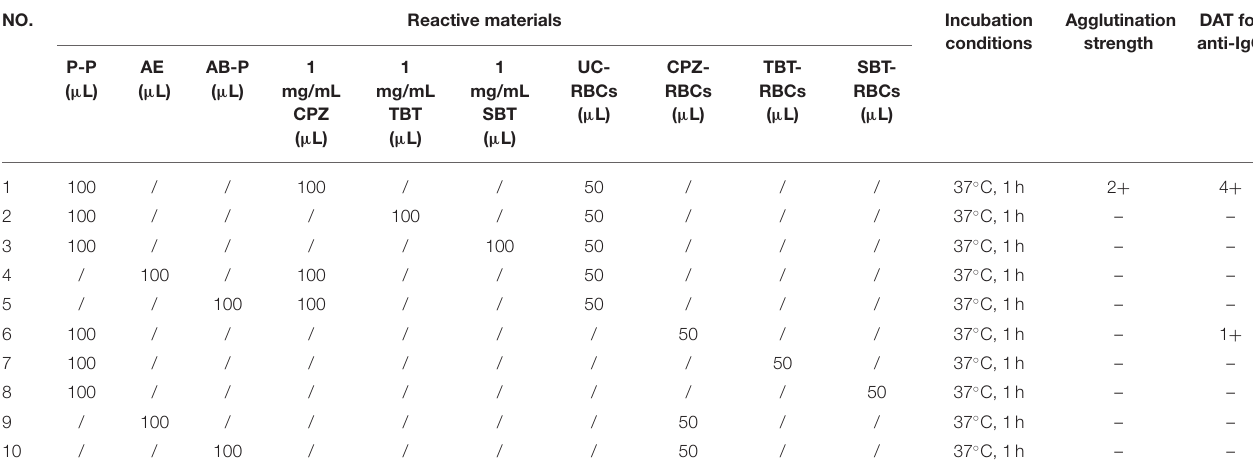
TABLE 1 | Results of drug-dependent antibody tests of blood samples collected 2 days prior to the discontinuation of cefoperazone treatment. NO. Reactive